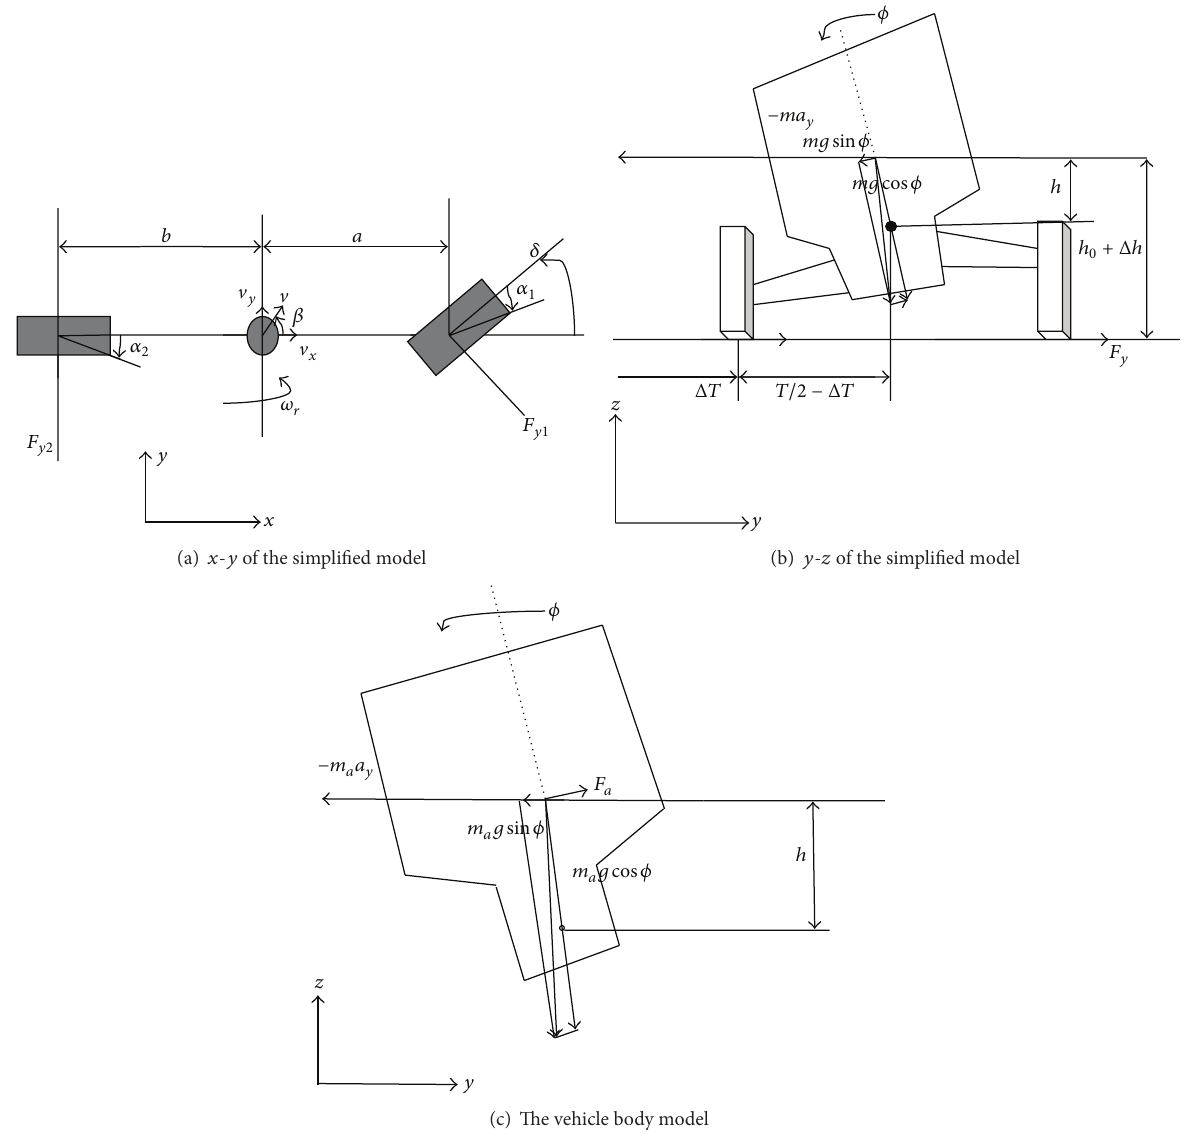
Figure 1: Simplified vehicle rollover